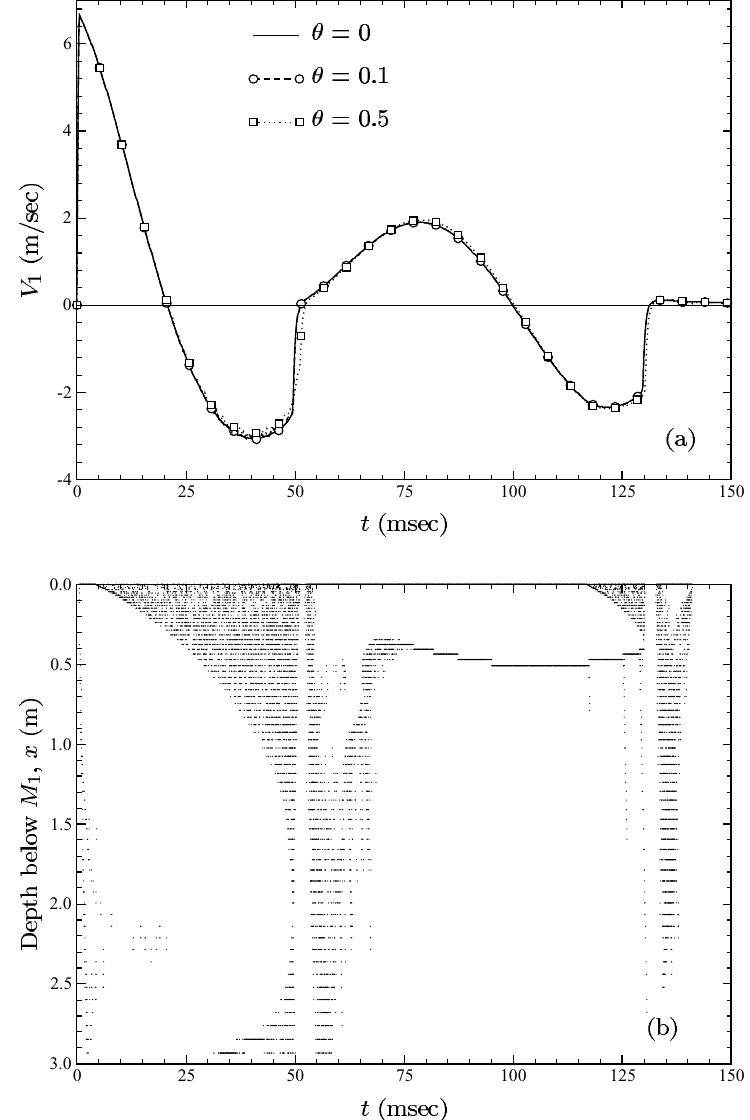
Fig. 14. (a) V 1 -response histories for M 2 /M 1 = 5 calculated with three θ values. (b) Fluid-change-of-phase plot for θ = 0 . 5